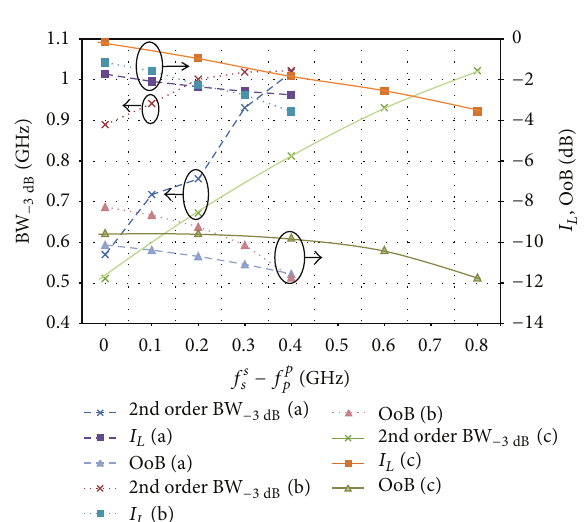
Figure 6: Comparison of transmission response ( 𝑆 21 ) of 2nd order FBAR filter of Filter 1 and Filter